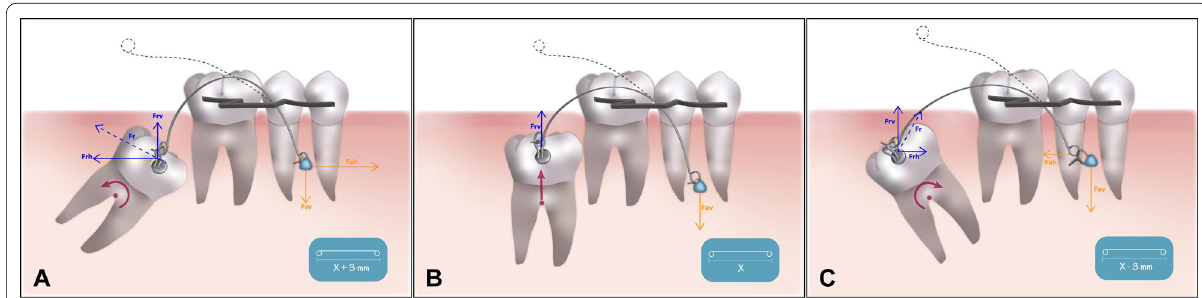
Fig. 1 Selection of the pole length depending on the included molar inclination: a mesial. b vertical. c distal. Force delivered to the pole arm and moment acting on the impacted/retained molar (pink). F r (blue), reciprocal force; F rv , vertical/extrusive component of F r ; F rh , horizontal component of F r . F a (orange), activation force; F av , vertical/extrusive component of F a ; F ah , horizontal component of F